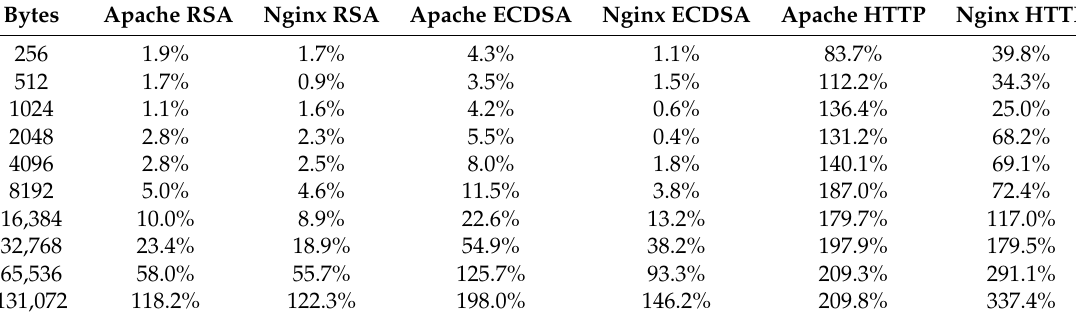
Table 3. Server-side page size versus energy consumption difference (in percentage) between GNU